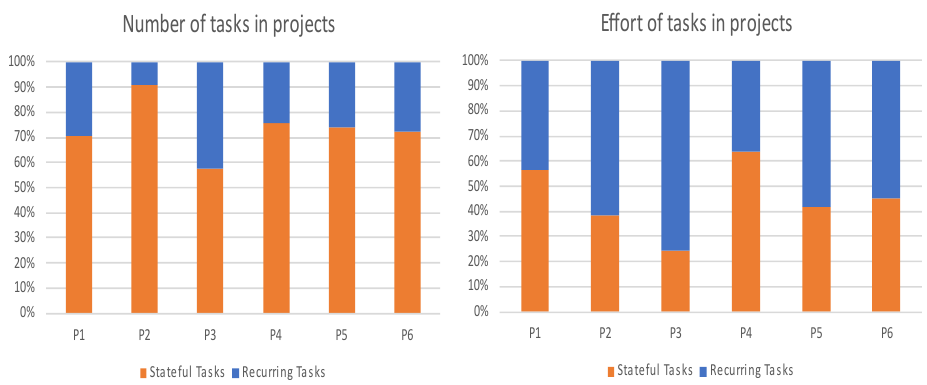
Figure 3. The number and effort of stateful and recurring tasks in the researched